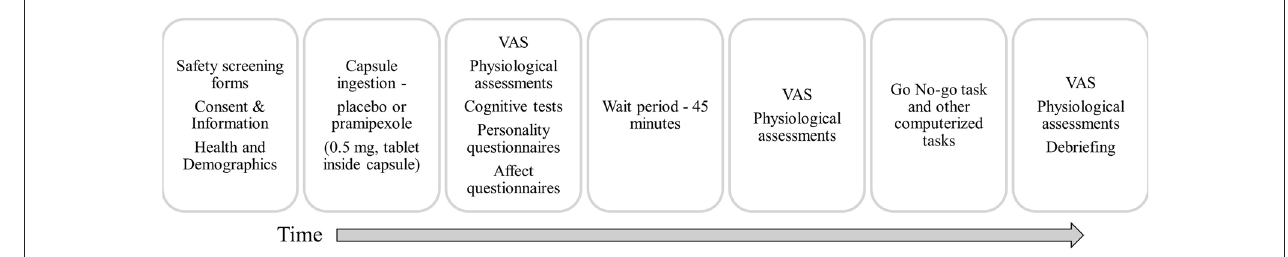
FIGURE 1 | Schematic outline of the experimental session. VAS, Visual Analogue Scale (Bond and Lader, 1974).